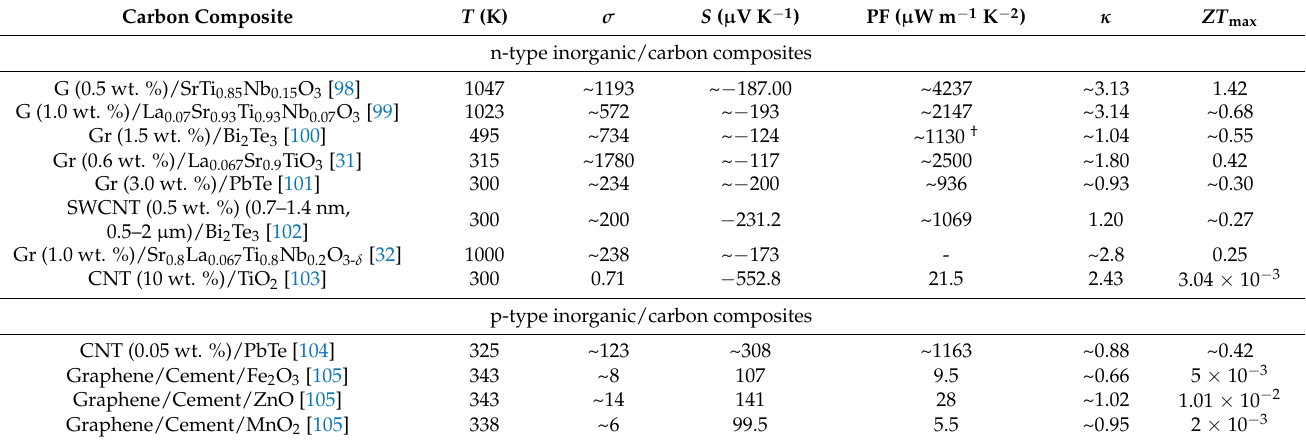
Table 3. Thermoelectric properties of inorganic/carbon thermoelectric composite materials. σ is electrical conductivity, T is temperature, S is the Seebeck coefficient, PF is the power factor and κ is the thermal conductivity. All values are reported at ZT max , figure of merit at its maxima. G = graphite, Gr = graphene. † Calculated from literature